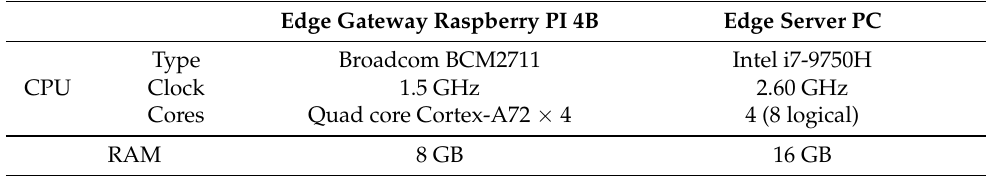
Table 2. The environments used to evaluate